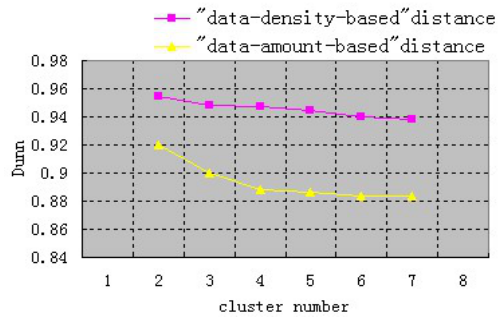
Fig.9. the Dunn value calculated by clustering with data- density-based and data-mount-based similarity of Center data